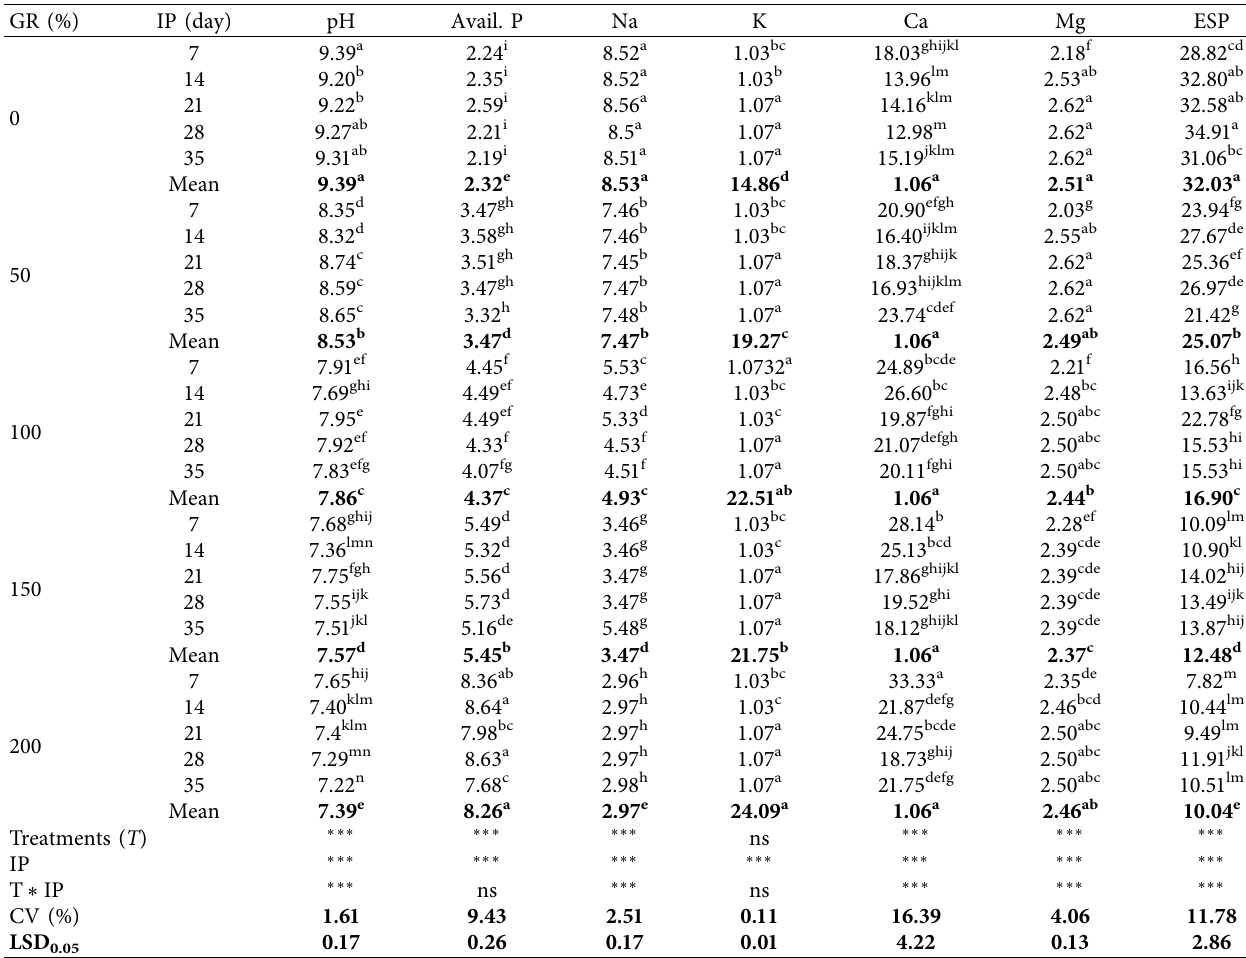
Table 2: Effect of incubation time on chemical properties of sodic soils within PG